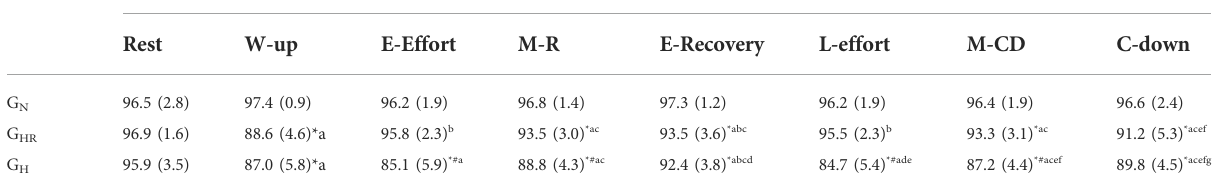
TABLE 2 Average peripheral oxyhemoglobin saturation (SpO 2 ) of each measurement of a set from the fi rst week of training. Group